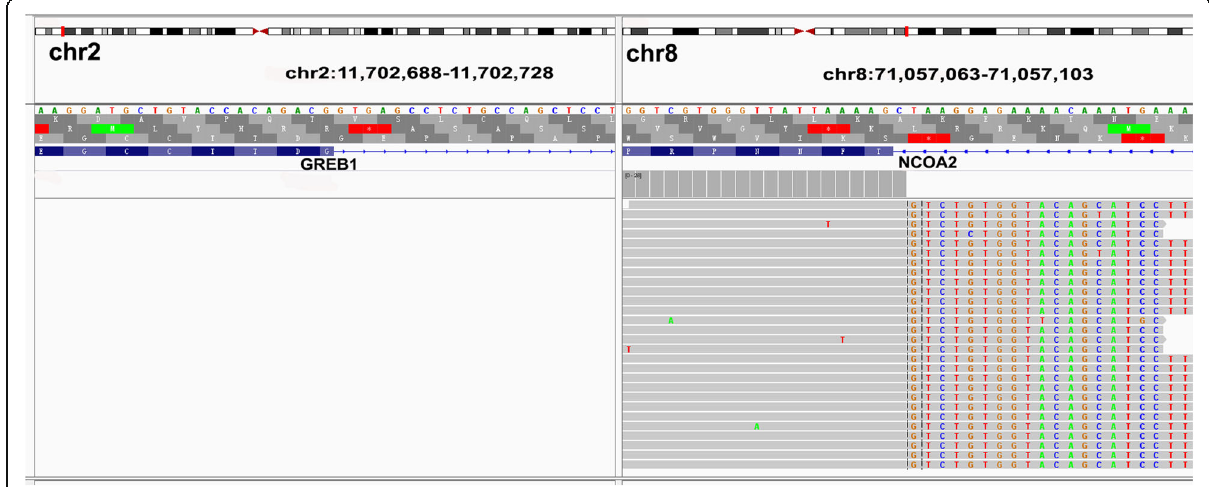
Fig. 3 Detailed RNA sequencing of fusion junction reads confirmed the presence of the GREB1-NCOA2 fusion